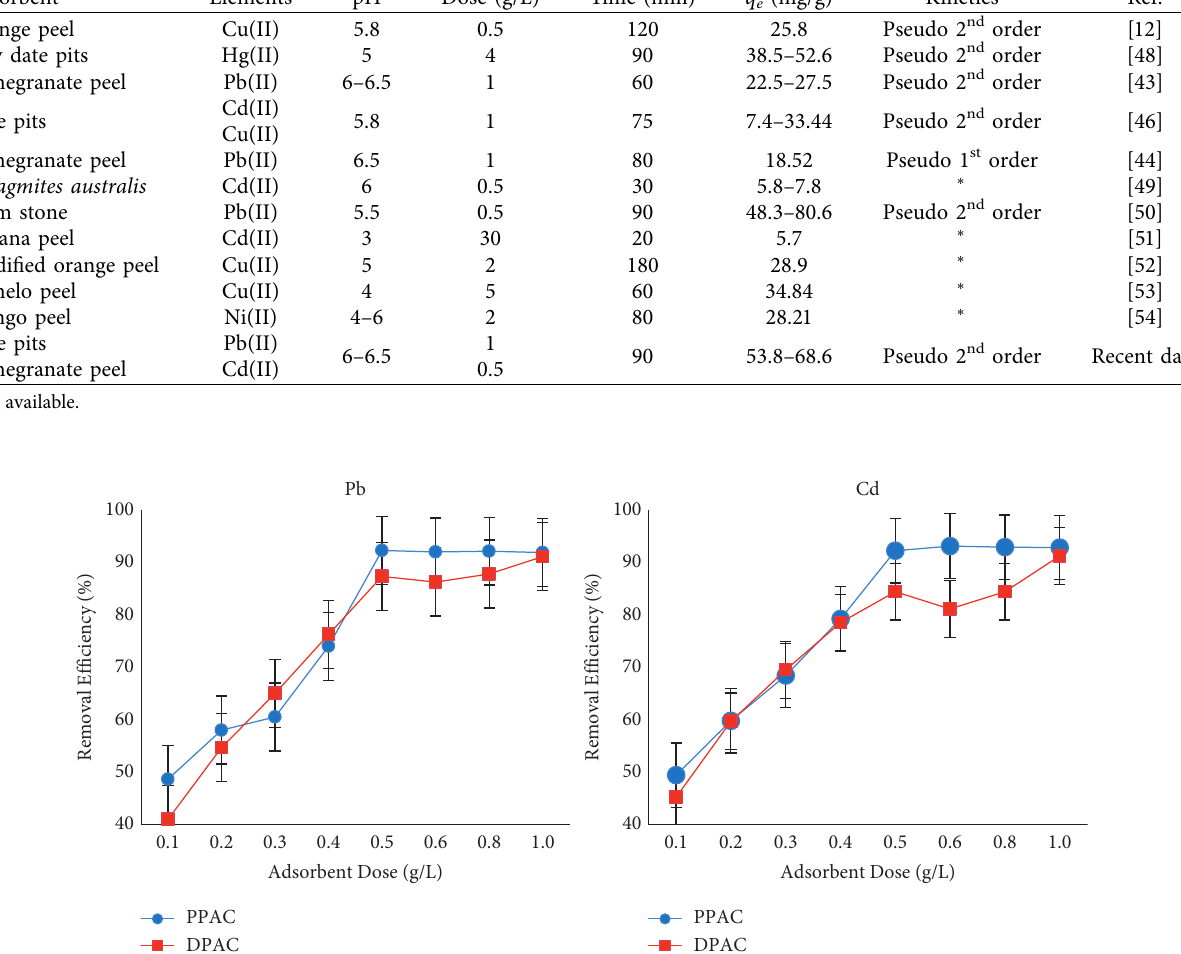
Figure 8: Effect of adsorbent dose on the adsorption of Pb(II) and Cd(II) (pH � 6, metal concentration � 100 mg/L, and contact time � 90min).